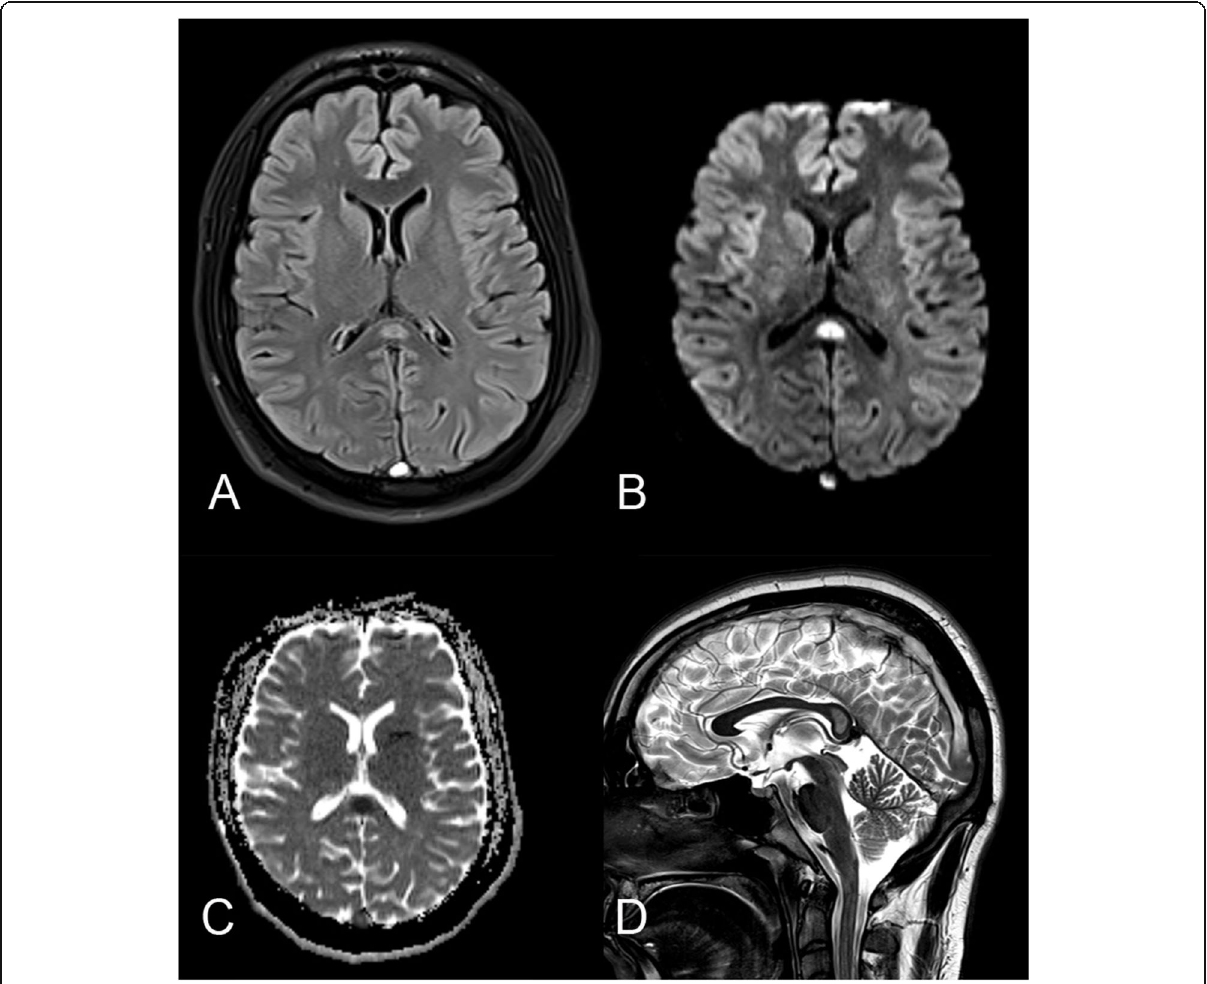
Fig. 3 Well-defined focal hyperintense lesion was seen in the splenium of the corpus callosum on axial T2/FLAIR ( a ) and sagittal T2 ( d ) images with corresponding area of restricted diffusion on DWI/ADC mapping ( b , c